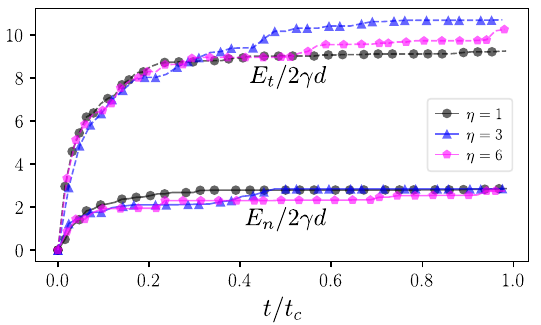
Figure 4. Evolution in time of cumulative energy consumption in mode traction and shearing for some of the samples at ✓ = 0.